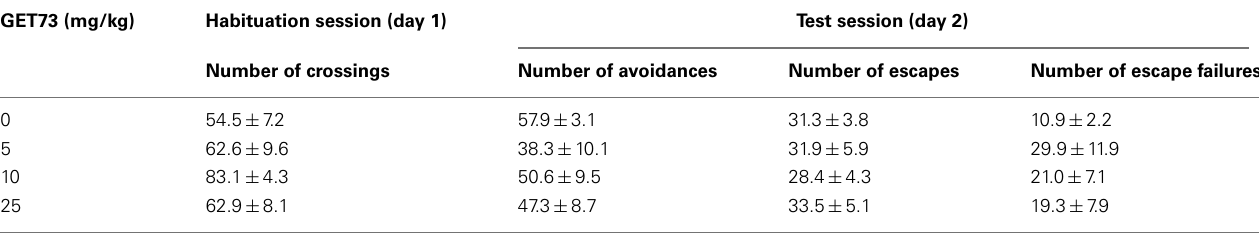
Table 3 | Effect of theacute, intraperitoneal administration of different doses of GET73 on a series of variables measured in habituation and test sessions in Sprague-Dawley rats exposed to theActiveAvoidance